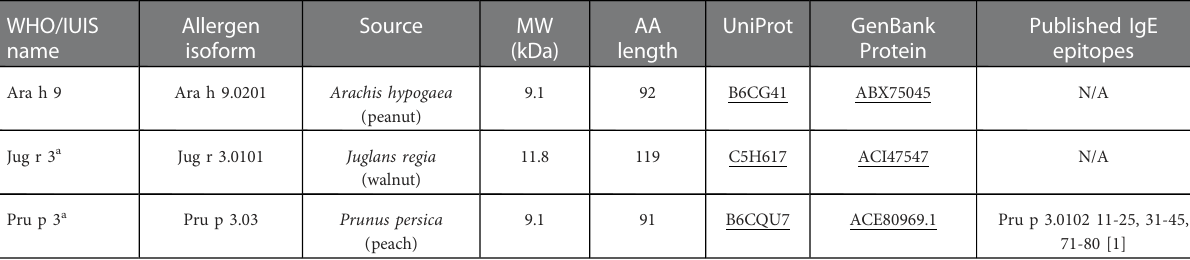
TABLE 3 Non-speci fi c LTPs analyzed in this